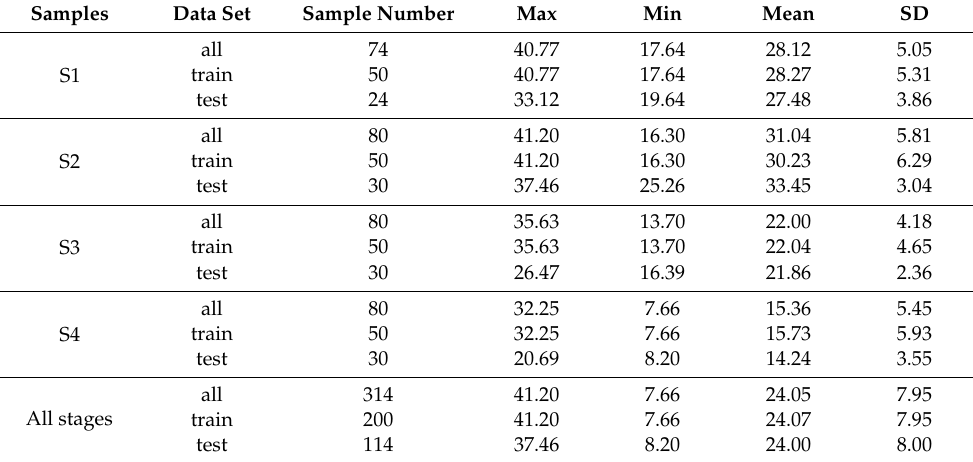
Table 2. Chlorophyll content statistics of training and test sets (mg / L).